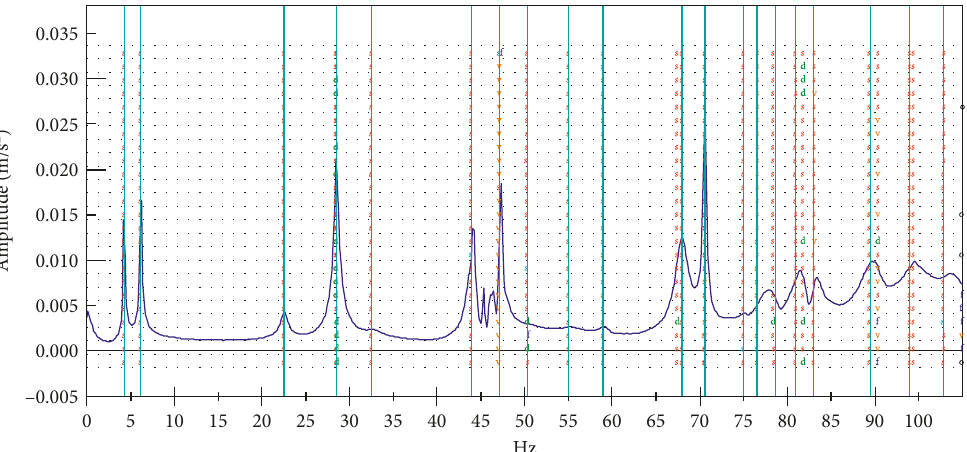
Figure 8: Stabilisation diagram for PolyMAX method (polyreference LSCF). Poles identified with an “S” represents a stabilisation in frequency, damping, and eigenvector. The blue solid line as the averaged sum of FRFs.